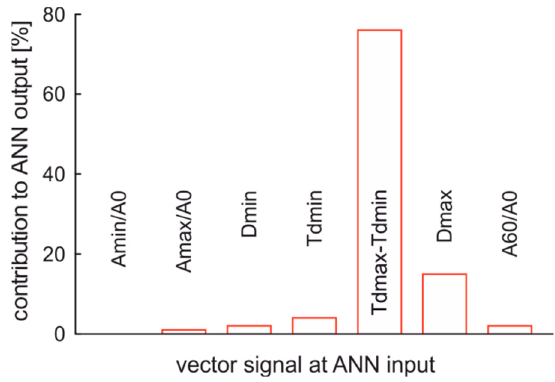
Figure 18. The contribution of input values to ANN classifier output of fuel state.